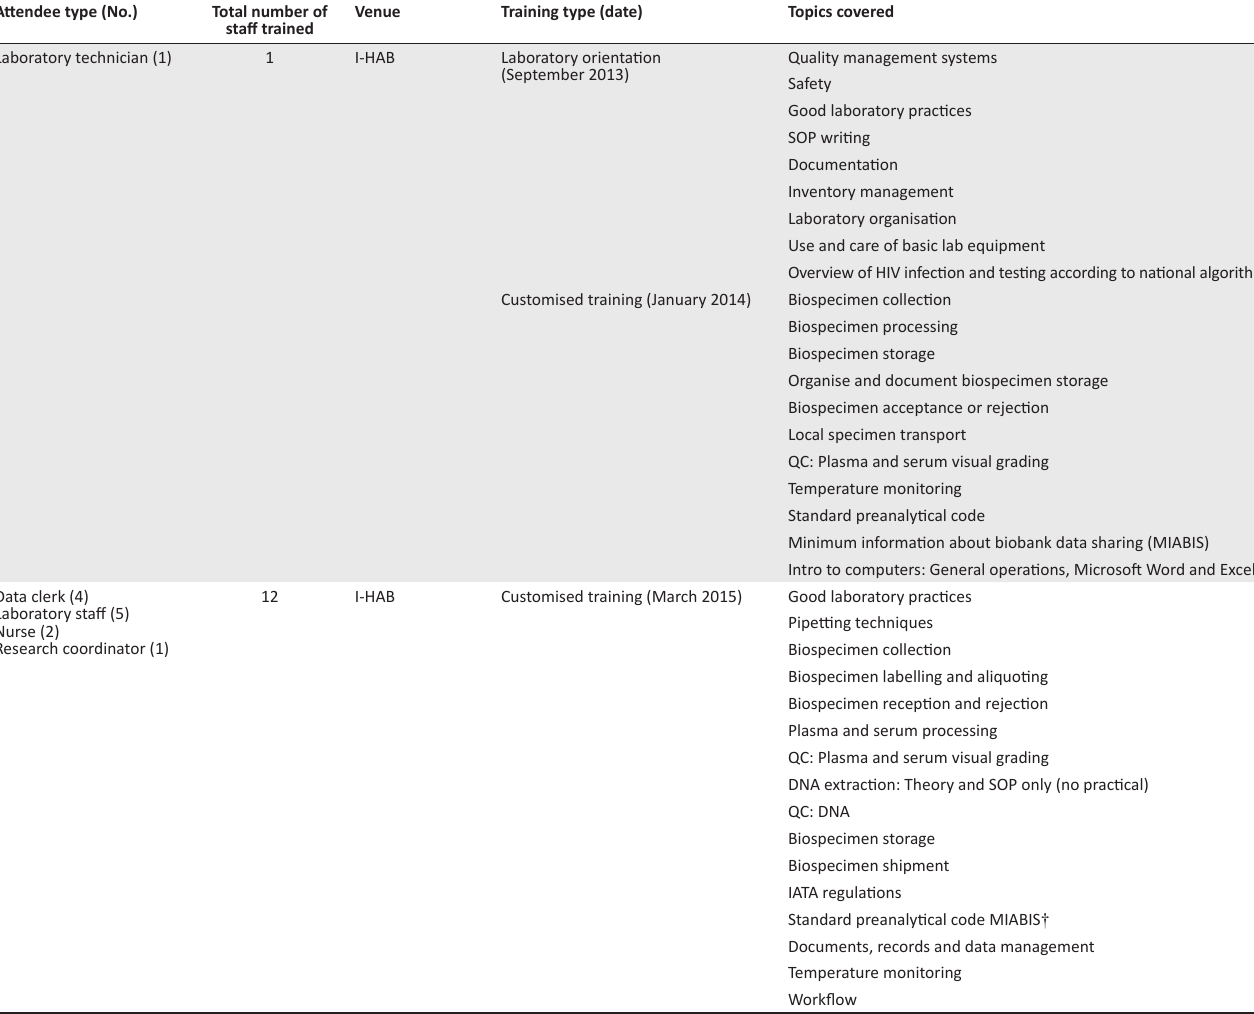
TABLE 1: Training topics to build knowledge and skills – Project A in Nigeria. Attendee type